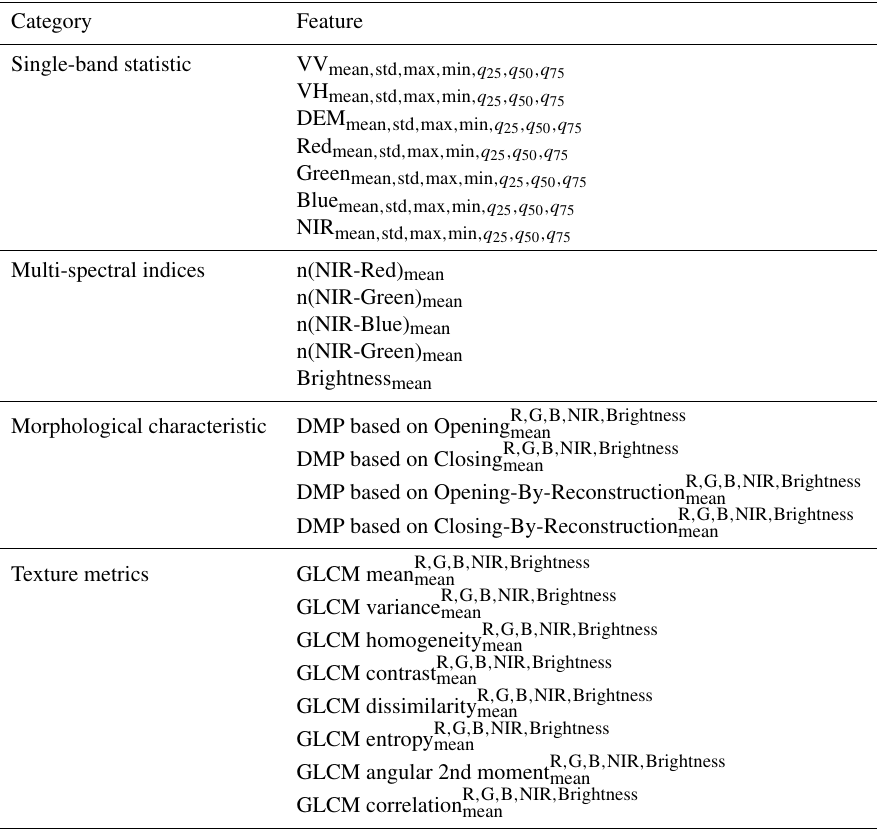
Table A1. Features extracted from Sentinel-1 and Sentinel-2 imagery as the inputs of ML models. More details on feature description and calculation methods can be found in Geiß et al. (2020); Haralick et al. (1973); and Pesaresi and Benediktsson (2001).